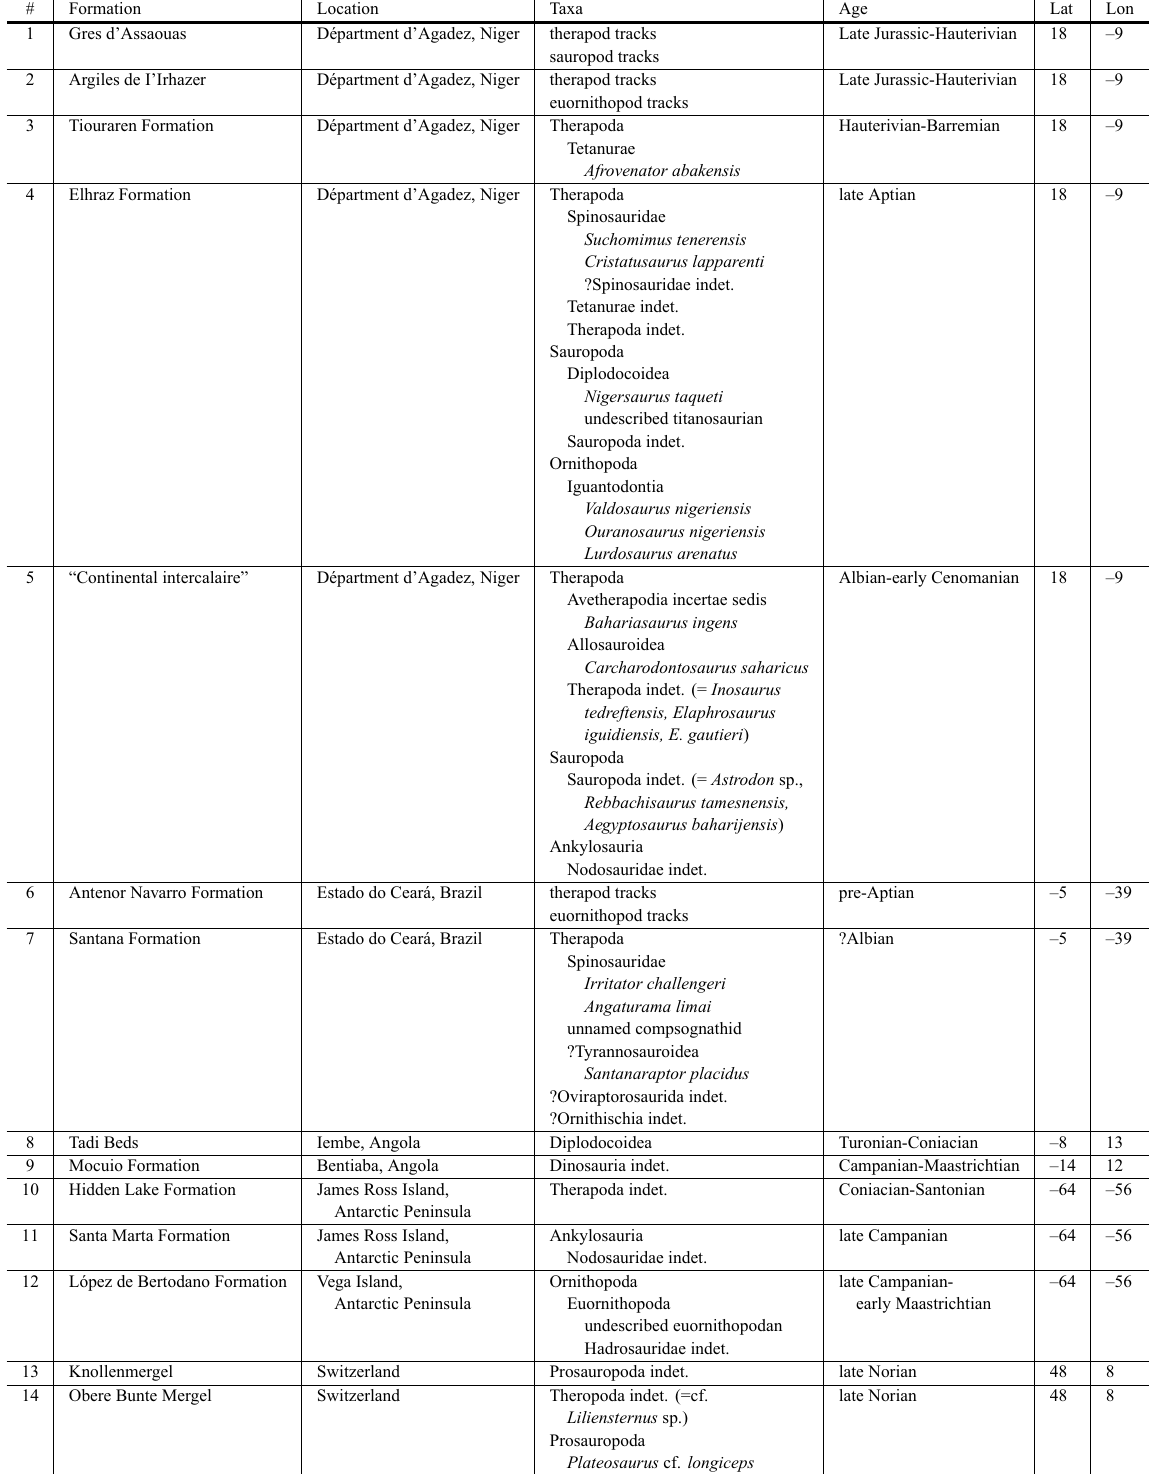
Dinosaur localities examined. Numbers as in Figure 1 and discussed in text. Data from Weishampel et al.